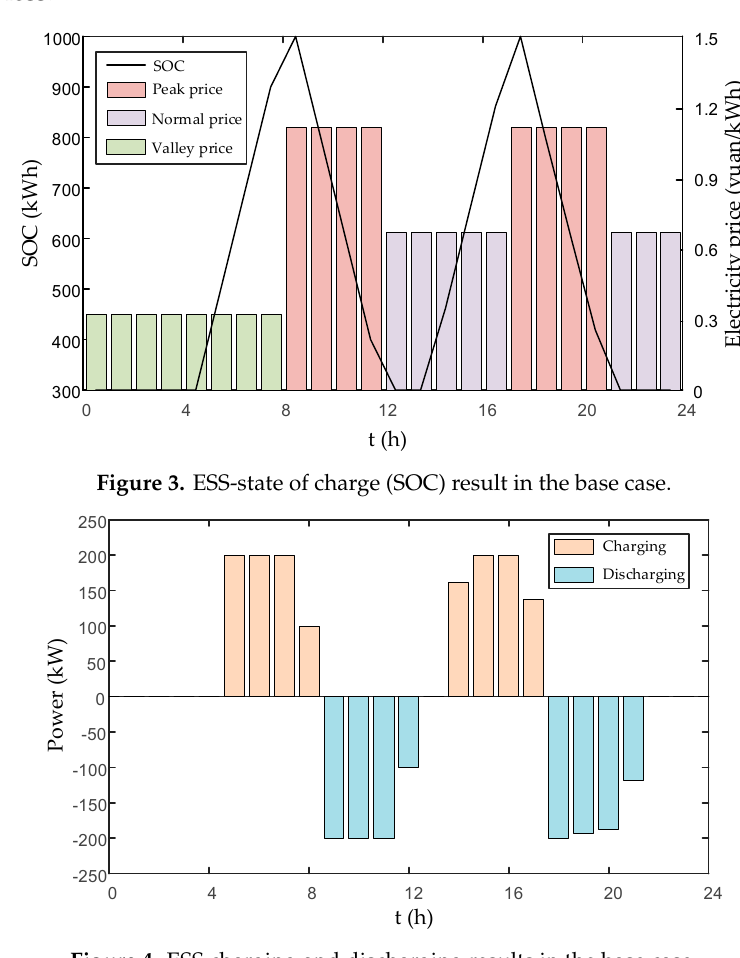
Figure 2. Typical load, PV, and WT profiles.